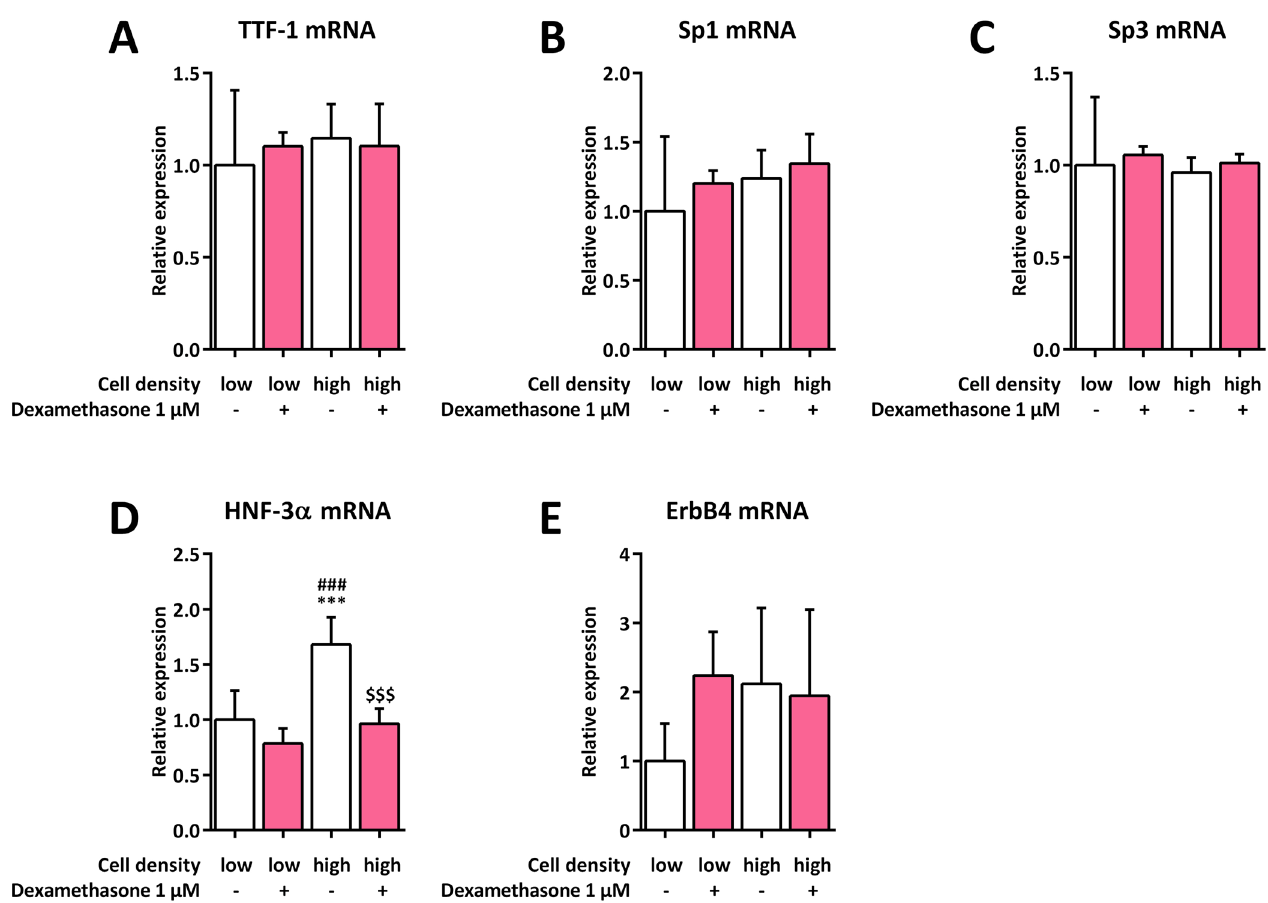
Fig 3. Impact of cell density on the expressionof SP-B transcription factor mRNAsin H441 cells. H441 cells were seeded at low (1 × 10 4 cells per cm 2 ) and high (7.5 × 10 4 cells per cm 2 ) densitiesand either left untreated or incubatedwith 1 μ M dexamethasone for 24 h. qPCR of TTF-1 ( A ), Sp1 ( B ), Sp3 ( C ), HNF-3 α ( D ), and ErbB4 mRNA ( E ) was performed, mRNA levels were normalized to those of GAPDH, and fold differences comparedto 1 × 10 4 untreated cells per cm 2 were calculated. Means +SD of n = 5 experiments are shown. *** p < 0.001 comparedto 1 × 10